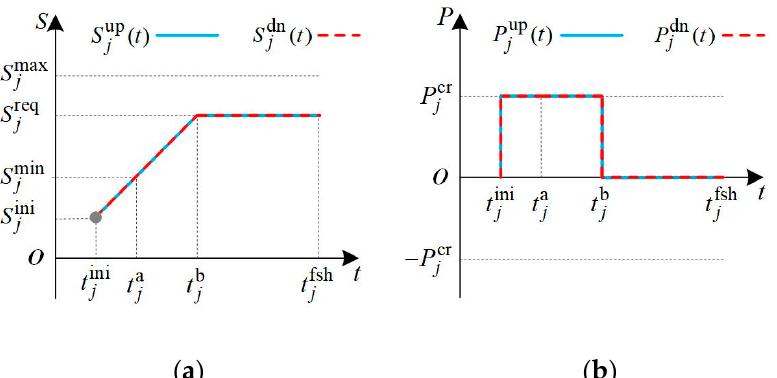
Figure 1. Regulation capacity of an EV with regulation mode 1: ( a ) SOC upper and lower boundaries; ( b ) power upper and lower boundaries.